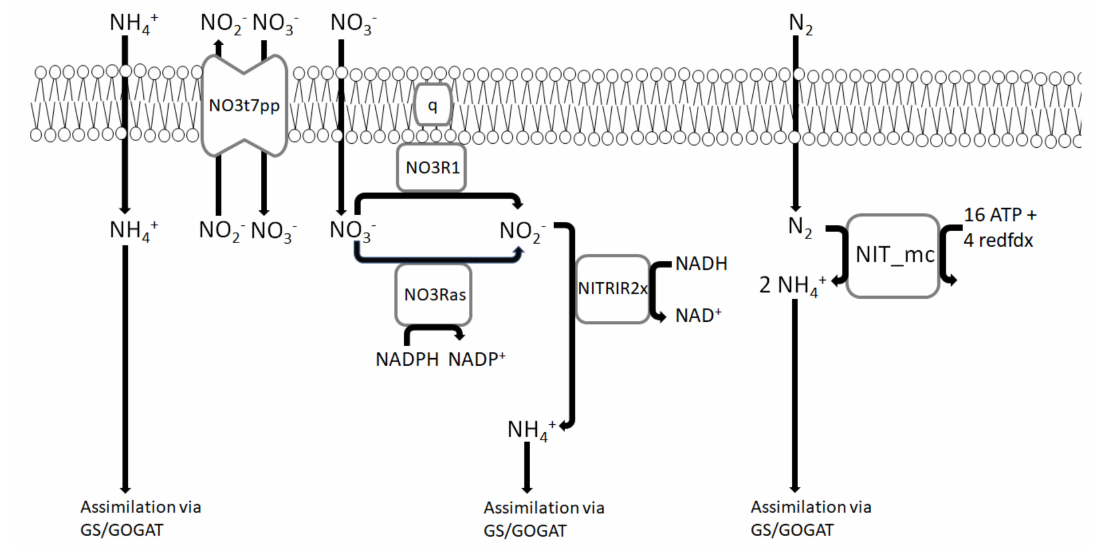
Figure 2. Nitrogen assimilation and fixation pathways implemented in iMsOB3b. NO3t7pp refers to nitrate transporter via nitrite antiport, q refers to ubiquinone. NO3R1 refers to NADP-dependent nitrate reductase, NO3Ras refers to ubiquinol-dependent nitrate reductase, NITRIR2x refers to NAD-dependent nitrite reductase, NIT_mc refers to nitrogenase, and redfdx refers to reduced